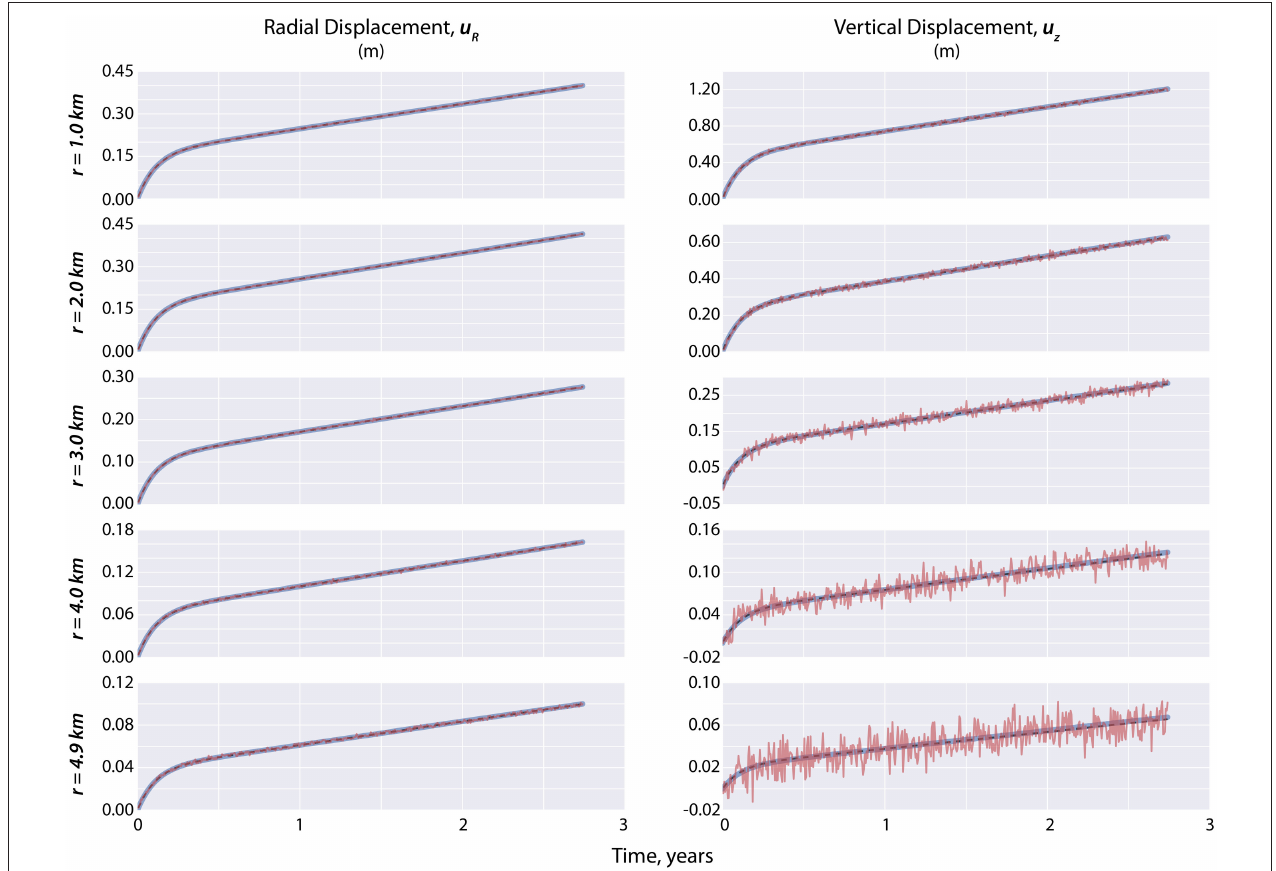
FIGURE 4 | The EnKF-estimated displacements after performing assimilation via state estimation (i.e., blue solid line) given that the prior distribution of the uncertain parameters are close to their true values ( Figure 3C ). The synthetic displacements used as D during assimilation are the noisy red lines that are more evident in the vertical component at far-field distances. The black broken lines correspond to the true